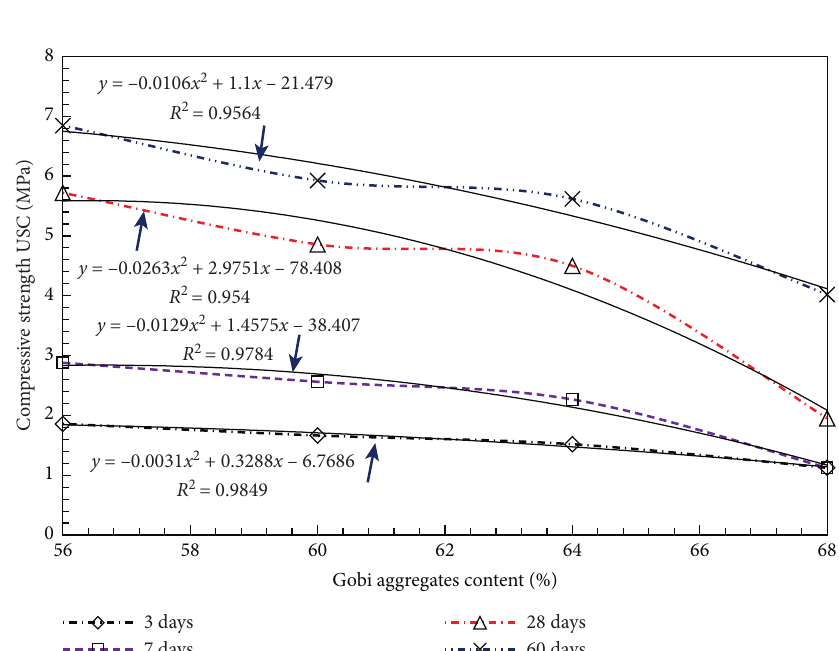
Figure 3: Effect of the Gobi aggregates content on the strength of CPB.